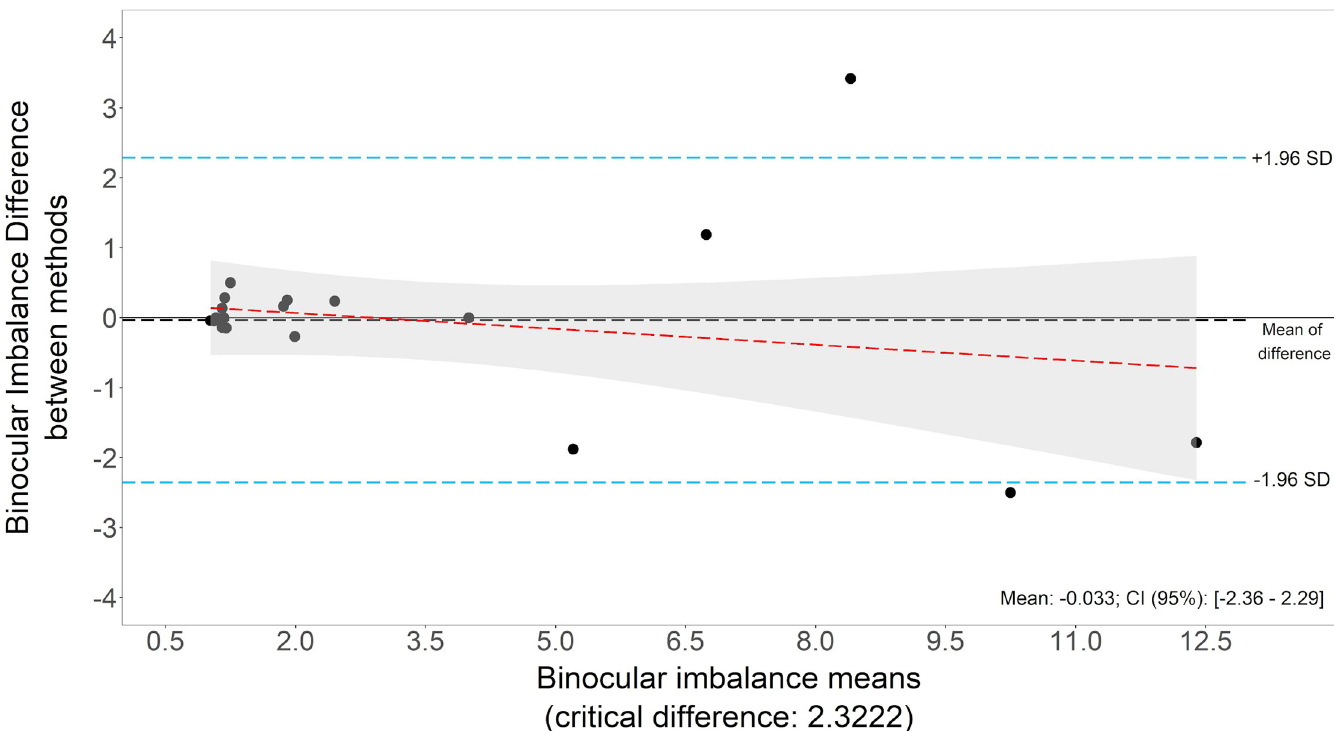
Fig 2. Binocular imbalance repeatability Bland-Altman plot. Binocular imbalance results in first and second measurements. N = 20 volunteers.